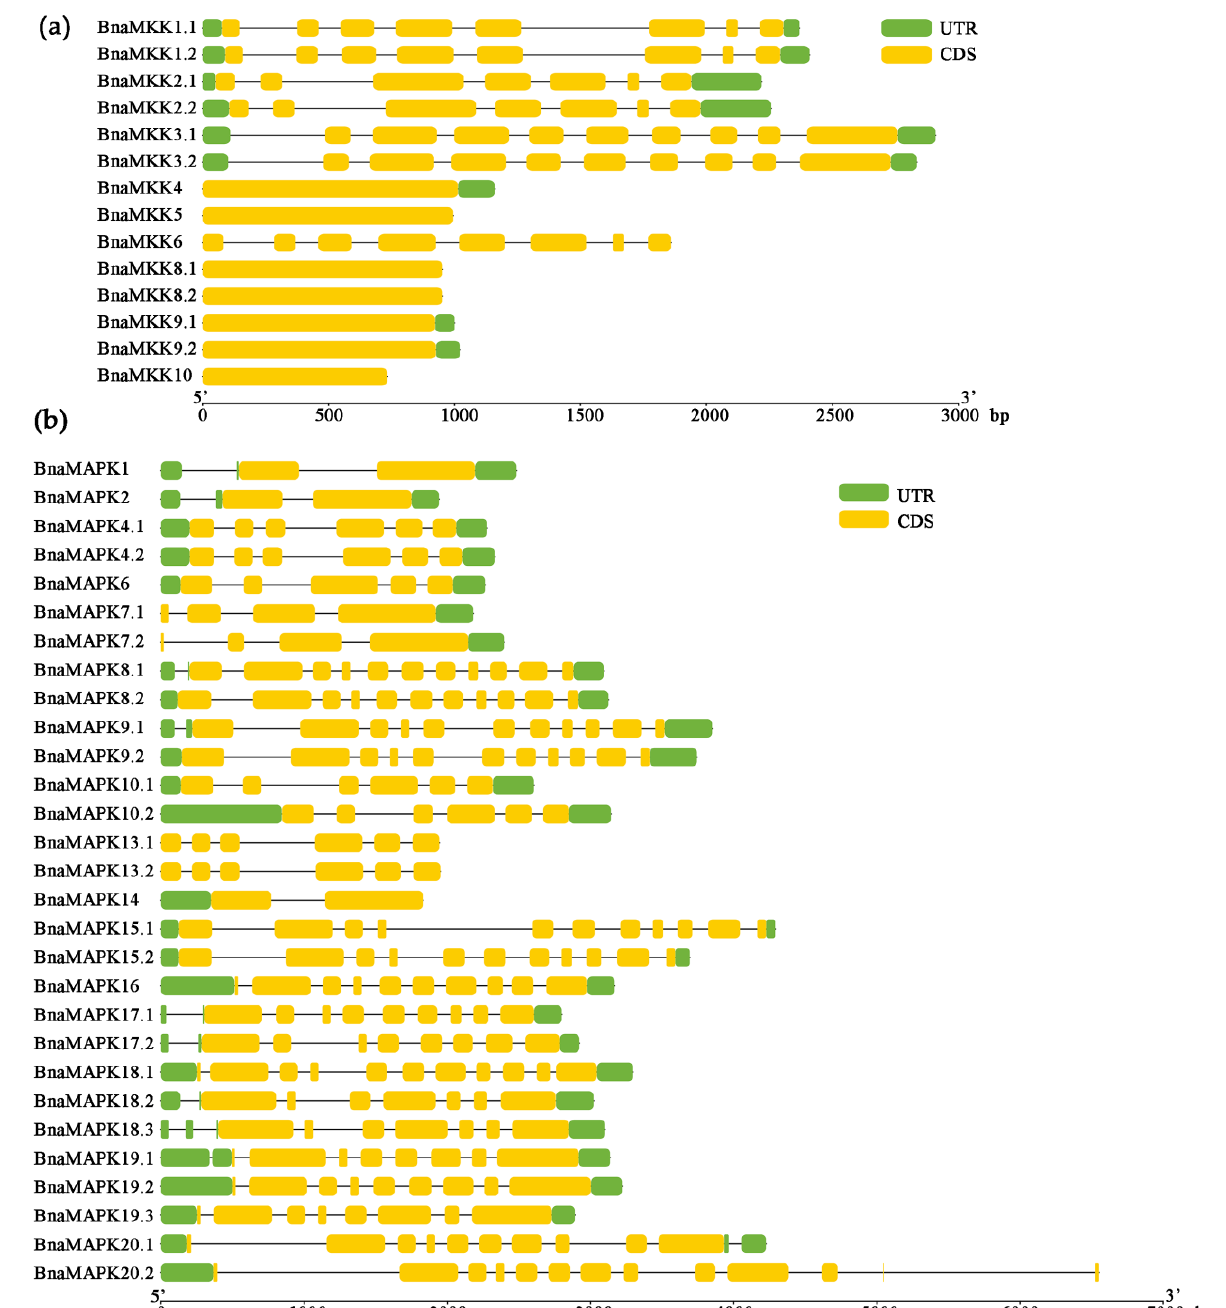
Figure 4. Gene structures of BnaMKK and BnaMAPK genes. ( a ) Exon–intron organization of BnaMKK genes. ( b ) Exon–intron organization of BnaMAPK genes. The untranslated regions (UTRs) are shown as green blocks, exons as yellow blocks, and introns as thin black lines.